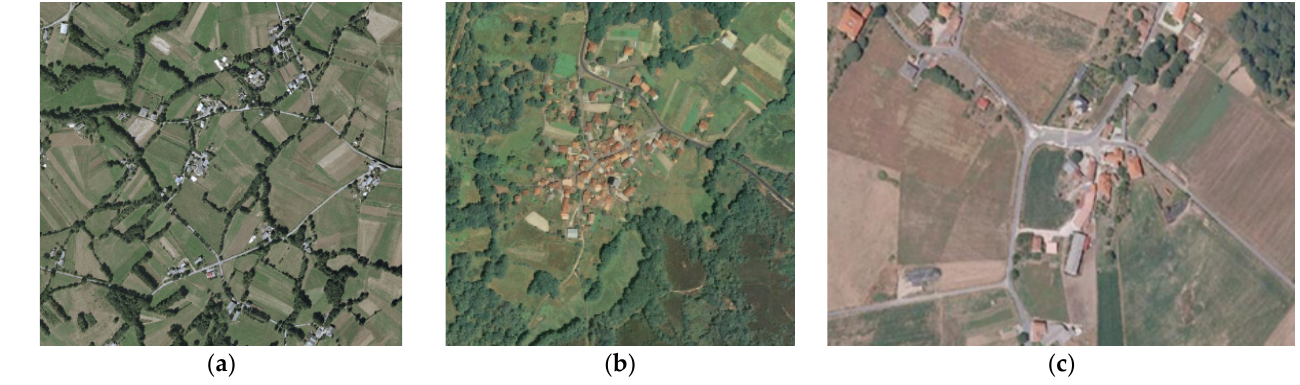
Figure 2. Different morphologies of rural settlements in Galicia: mixed ( a ), concentrated ( b ) and dispersed ( c ). Source: Authors.